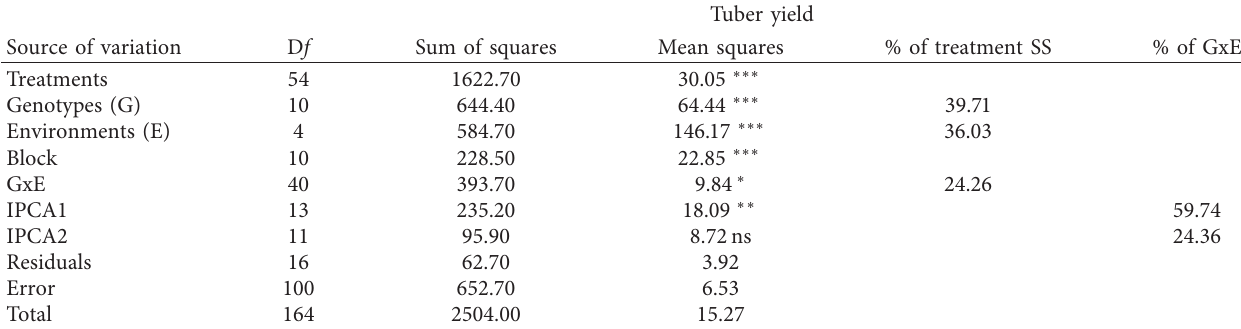
Table 3: AMMI analysis of variance for 11 elite yam genotypes evaluated in five environments for tuber